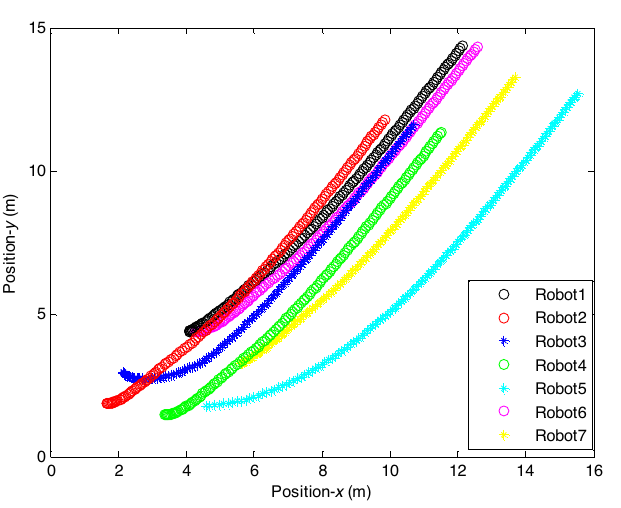
Figure 8. Consensus control of seven